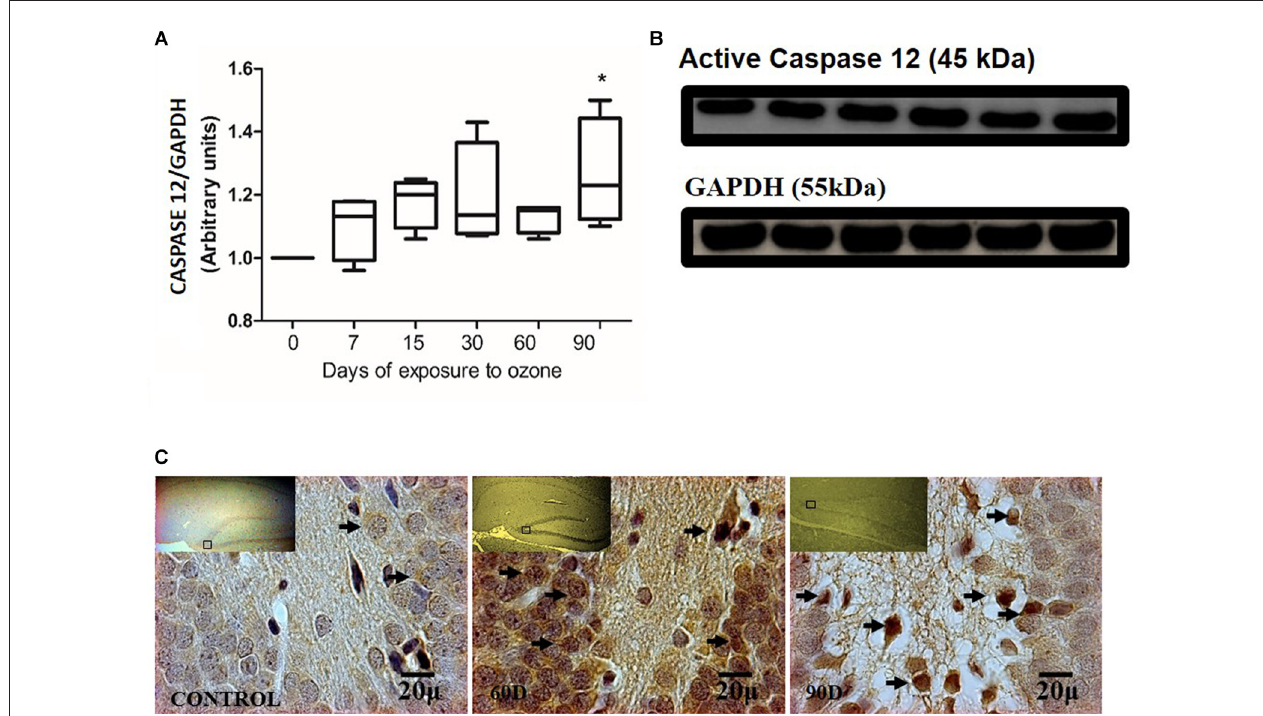
FIGURE 3 | Effect of chronic exposure to ozone on caspase 12 expression in rat hippocampus. (A) Shows the densitometry analysis of the protein levels for caspase 12 from rat hippocampus following exposure to ozone for 7, 15, 30, 60 and 90 days. There is a significant increase at 90 days of exposure to ozone. (B) The results show an increase in the protein expression following 60 and 90-day exposure to ozone ( ∗ p < 0.05) compared with the control groups. GAPDH staining was used as an internal control. (C) Effects of ozone treatments on caspase 12 immunoreactivity in the dentate gyrus of rat hippocampus. Light photomicrographs show immunoreactivity for caspase 12 in cells from hippocampus of rats exposed to ozone. The control group showed low immunoreactivity. We observed an increase of immunoreactivity for caspase 12 at 60 and 90 days of exposure to ozone. Arrows show caspase 12 immunoreactivity 100 × . The square indicates the area that is shown as 100 ×